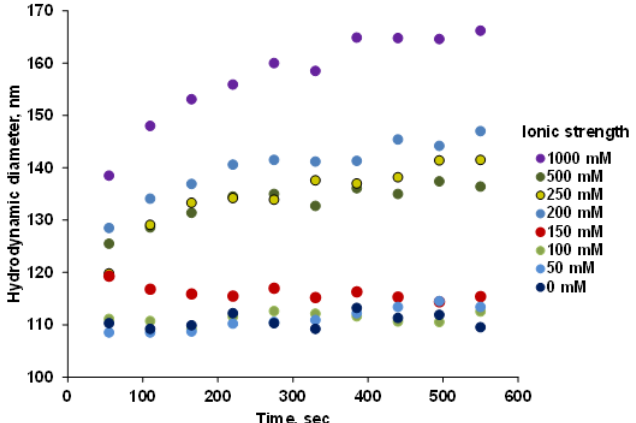
Figure 6. Changes in the kinetics of coagulation of P(PEGMA-AA)@MNP with 1.2 mmol COOH/g MNP loading measured at pH ~ 6.5 as a function of ionic strength.